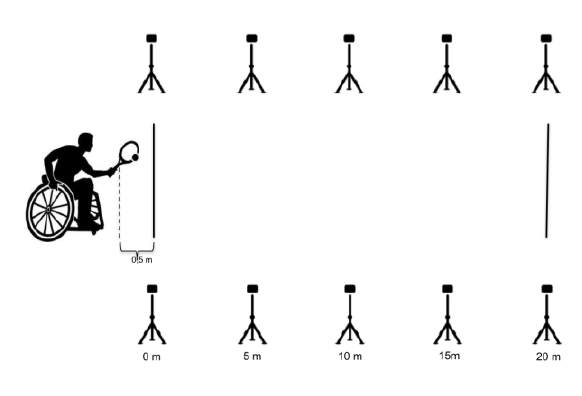
Figure 1. 20 metres wheelchair tennis test. Adapted from Sánchez-Pay & Sanz-Rivas, 2019. Reprinted with